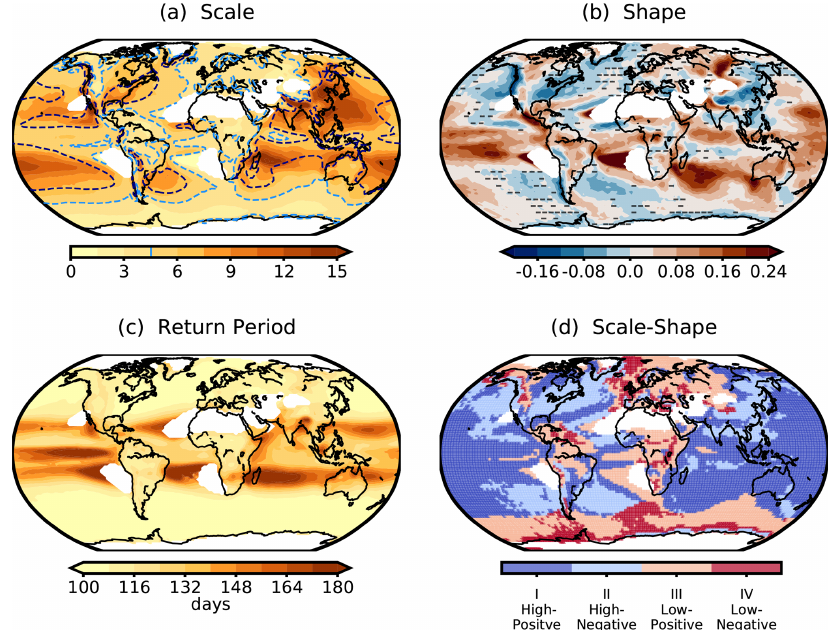
Figure 8. (a) Scale, (b) shape parameters of the stationary GPD models, (c) return periods of extreme thresholds (see Fig. 7), and (d) the combination of the scale and shape parameters with: above (high) and below (low) the median of the scales, and positive and negative shape parameters. On the composite of scale parameters in panel (a) , the wet region in Fig. 7 is denoted as a dashed dark blue line, and the median of scale parameters is overlaid as a dashed light blue line. Again, the regions where the annual total precipitation is less than 250mm are marked as